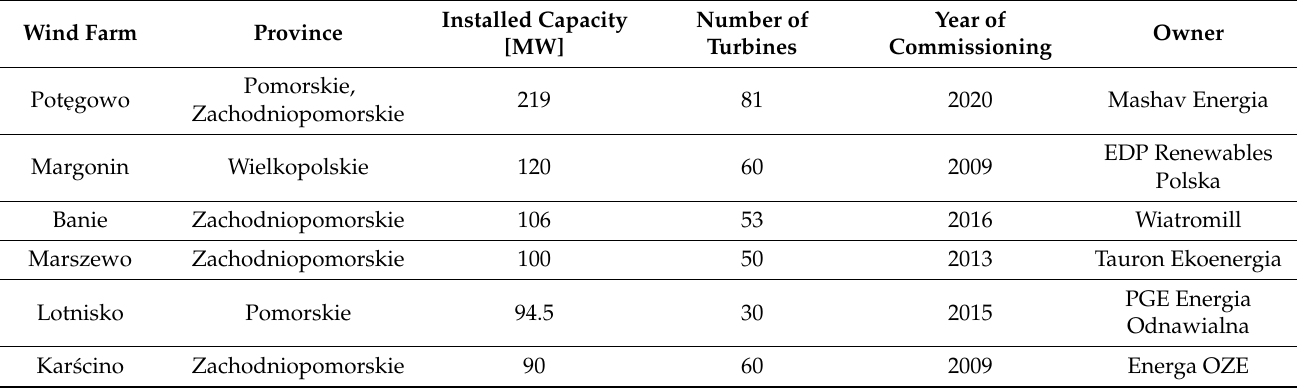
Table 1. The largest wind farms in Poland in 2022